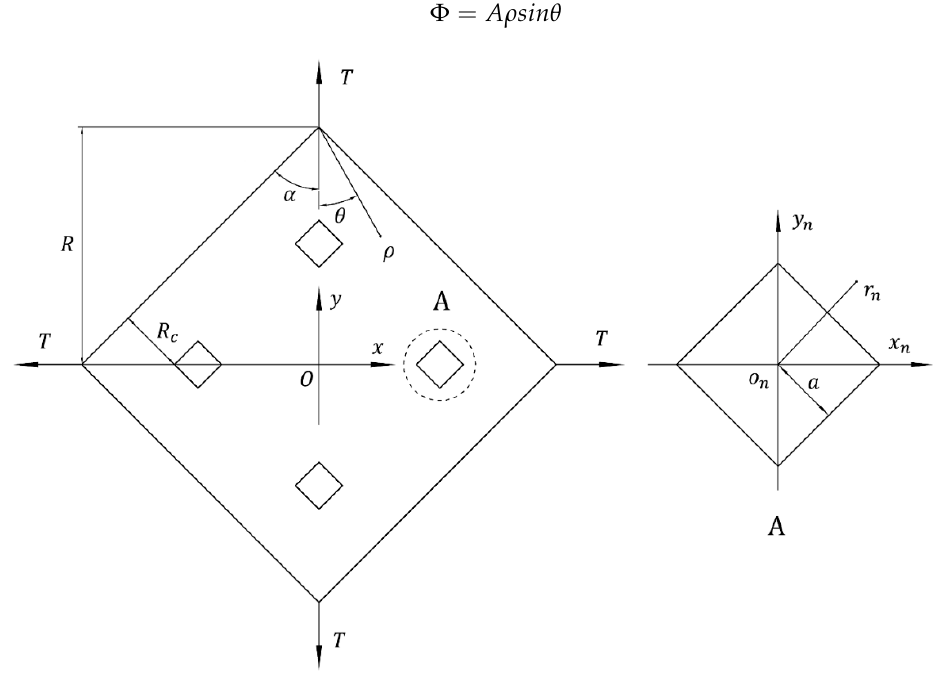
Figure 1. Schematic diagram of heterogeneous film structure.